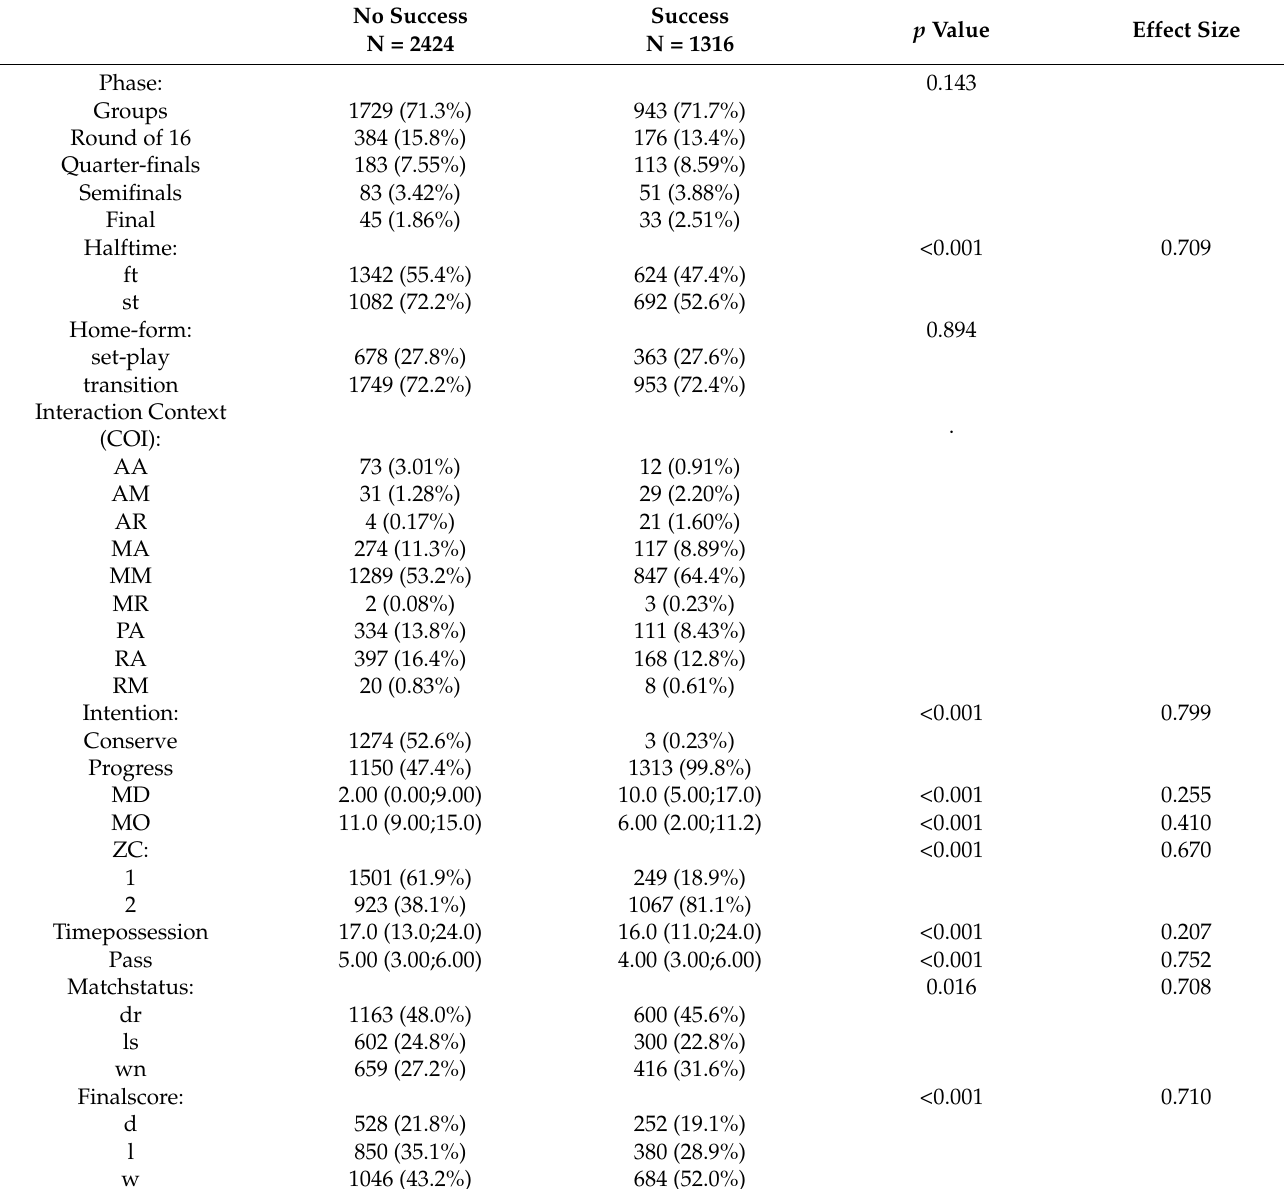
Table 2. Summary of the descriptives by groups of “move